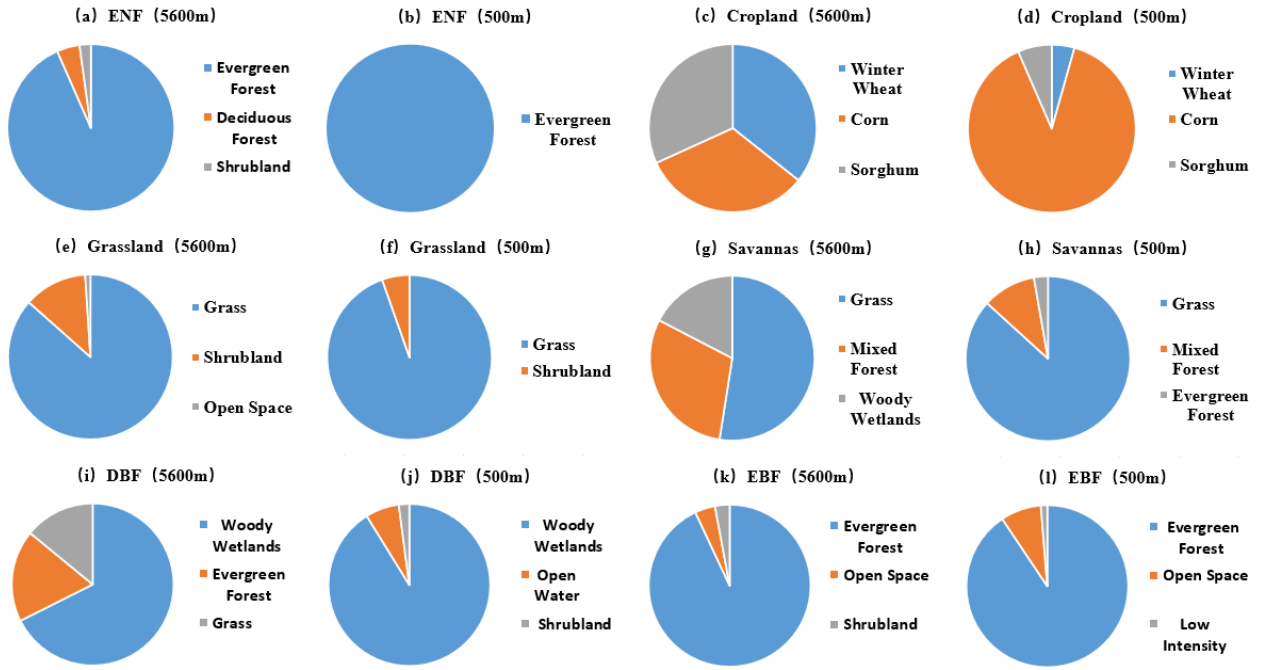
Figure 2. The proportion of categories in MODIS pixels (5600 m and 500 m) for each study site based on CDL (first three categories).